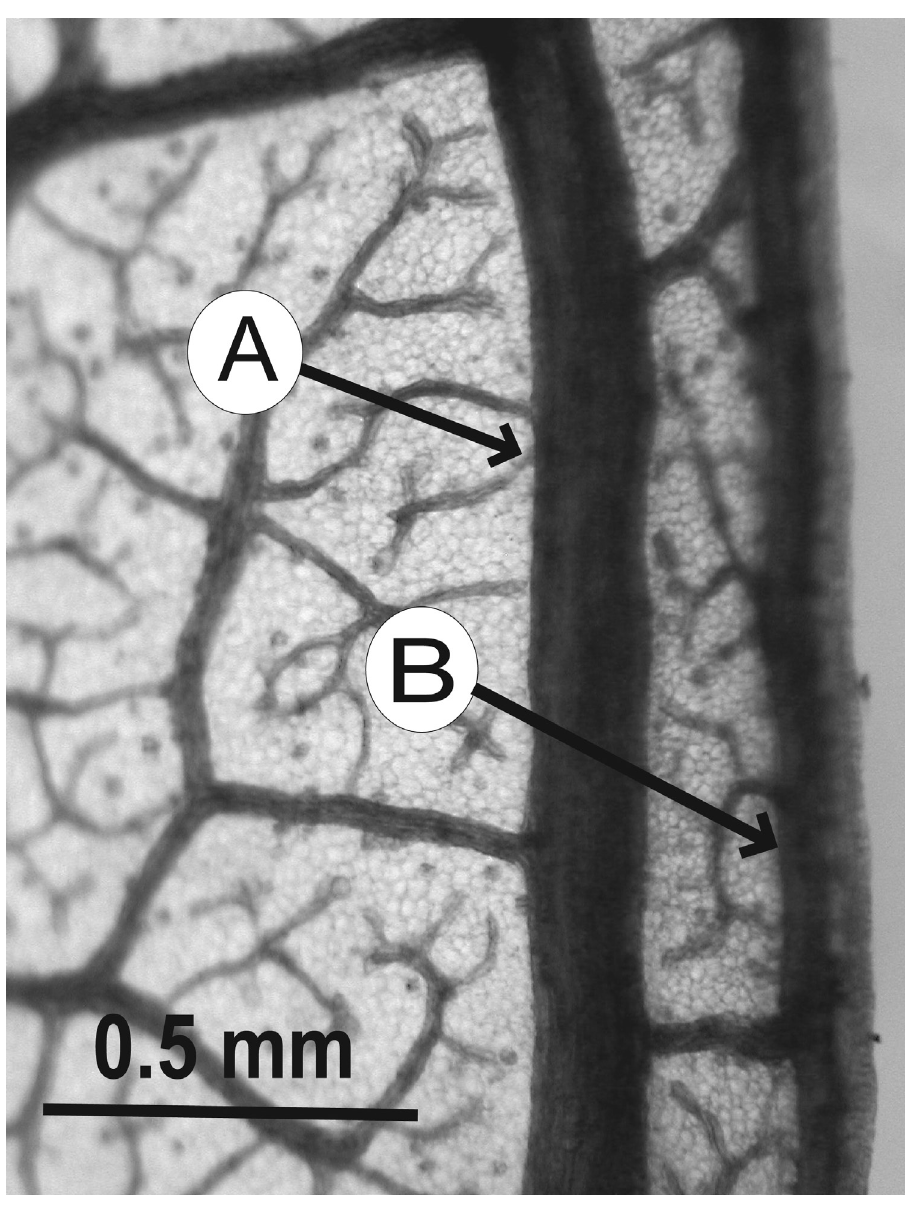
Figure 9. Leaf architecture of Spondias mombin (contd.) . A Intramarginal vein B Fimbrial vein. (from Hopkins 1454 ,